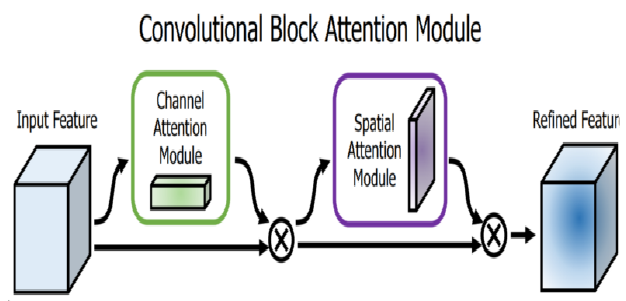
Fig12: How yolov4 framework processes images from video